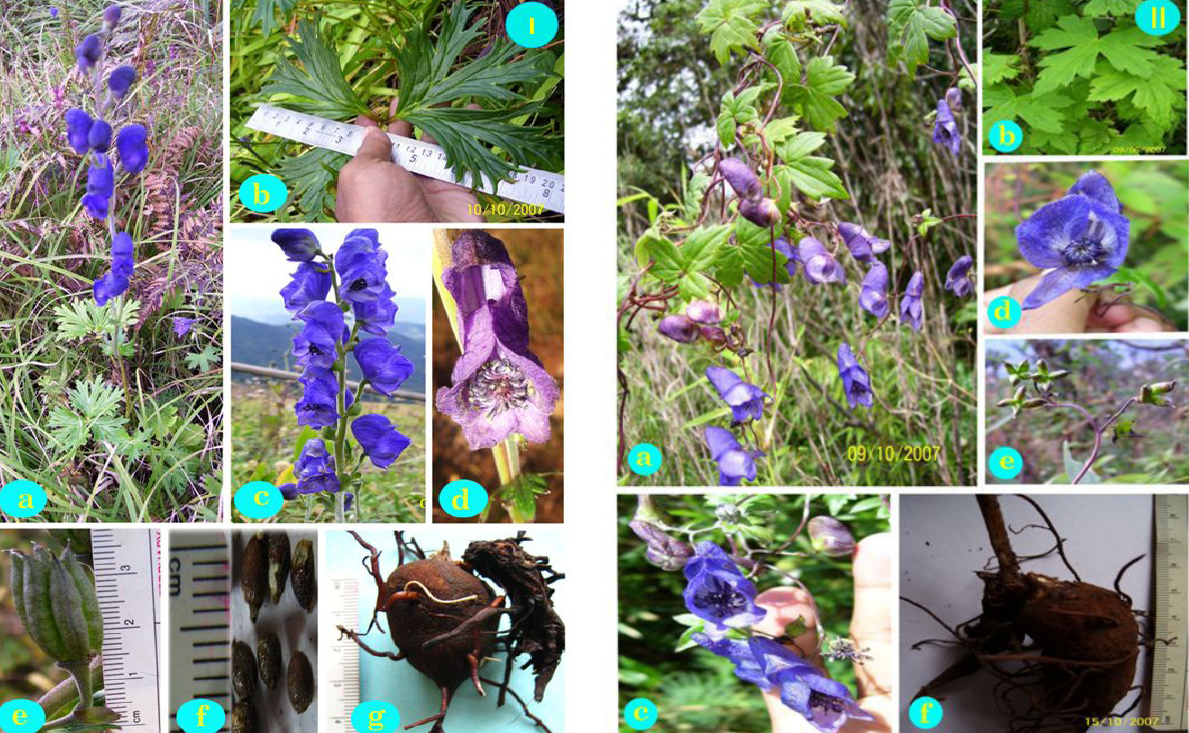
Fig. 1. I. Morphological features of Aconitum nagarum , a: Habit, b: Leaf, c: Inflorescence, d: Single flower, e: Fruit, f: Seed, g: Root; II. Morphological features of Aconitum elwesii , a: Habit, b: Leaf, c: Inflorescence, d: Single flower, e: Fruit, f: